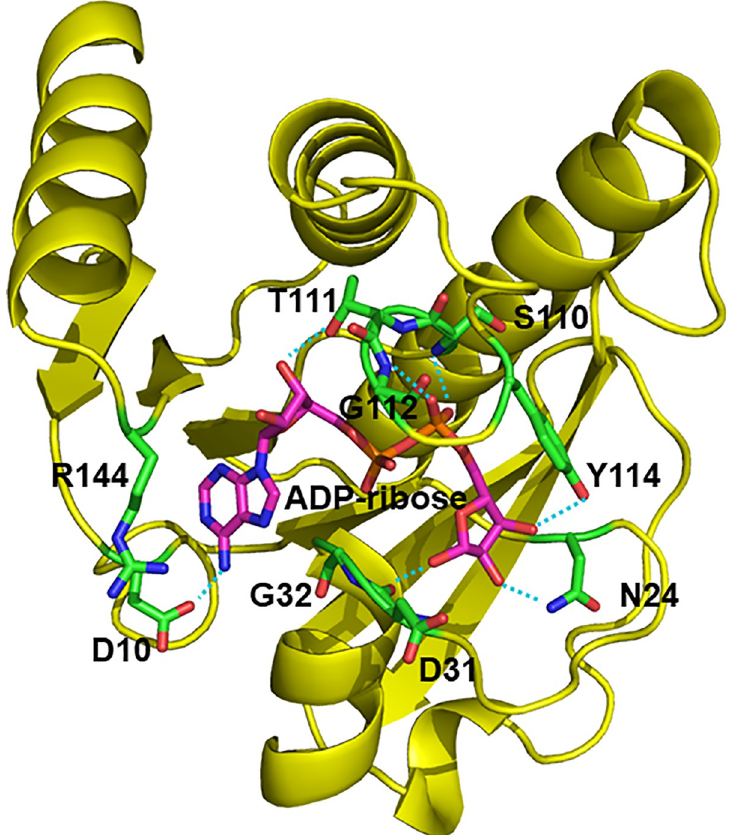
Fig 1. The co-crystal structure of CHIKV nsP3MD with ADP-ribose. CHIKV nsP3MD structure is shown in yellow cartoon. ADP-ribose is shown in magenta sticks in the center of the cavity. Residues of nsP3MD that interact with ADP-ribose are shown in green sticks. The hydrogen bonds between nsP3MD and ADP-ribose are shown in cyan dashed lines. All graphic presentations for molecular structures were generated using Pymol [49].